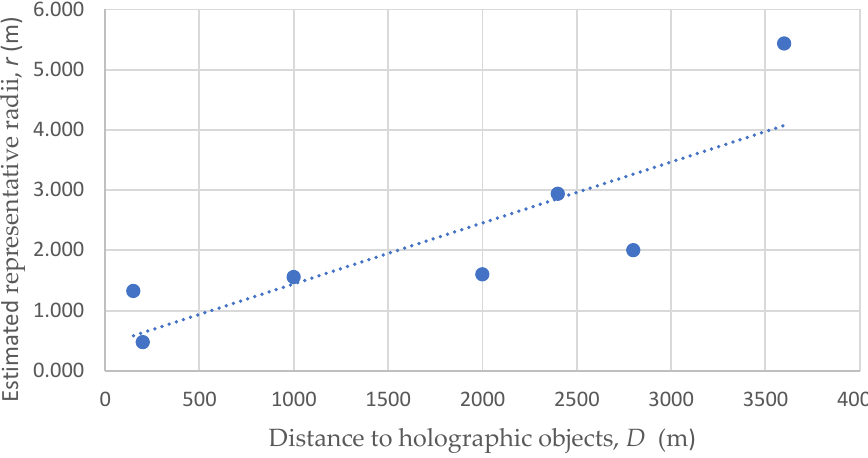
Figure 10. Linear regression estimation curve for the representative hologram (sphere) radii as a function of distance.